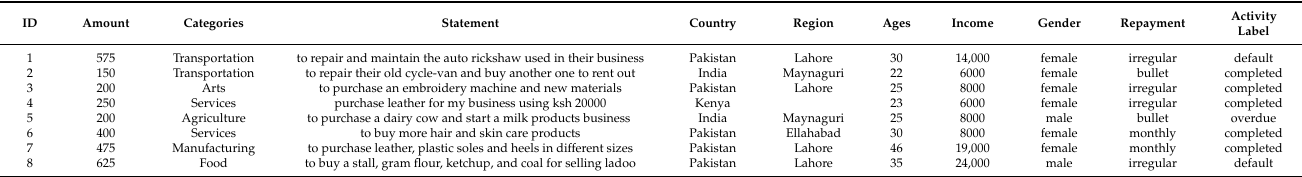
Table 3. Examples of the user applications.